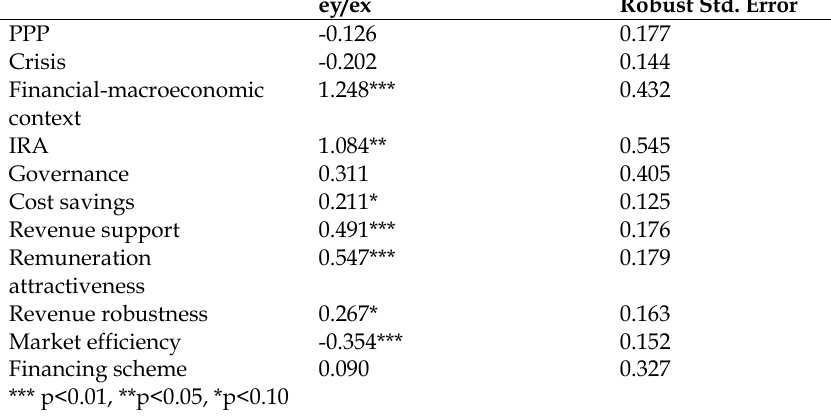
Table 4. Elasticities of the revenue and the traffic